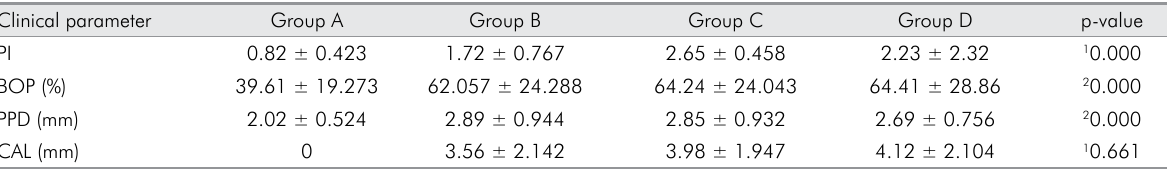
Table 2. Clinical periodontal parameters.